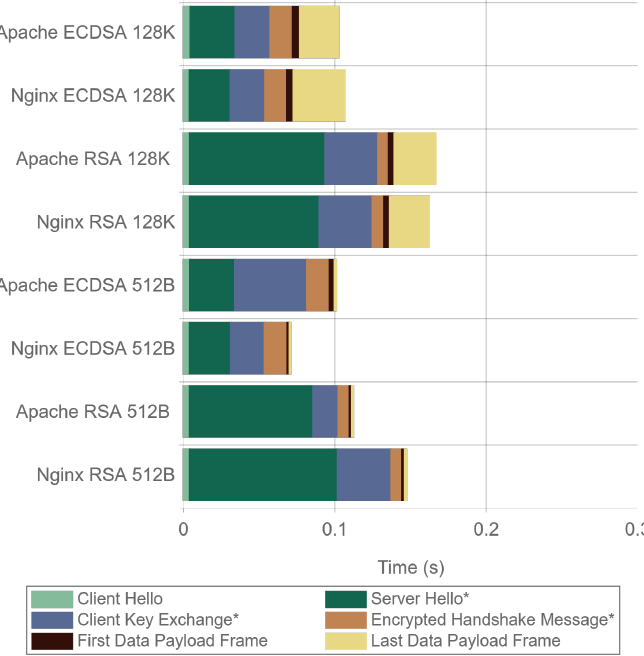
Figure 23. Time elapsed until each main step of the Transport Layer Security (TLS) handshake, start and end of the data transmission. * The frame contains several messages besides the Server Hello/Client Key Exchange/Handshake Messages. Table 6. Total data and frames transmitted using GNU ZIP (GZIP) and no compression for 512 byte and 128 kilobyte payloads. No Compression GZIP 512 Bytes 128 Kilobytes 512 Bytes 128 Kilobytes Server and Cipher 1 Bytes Frames Bytes Frames